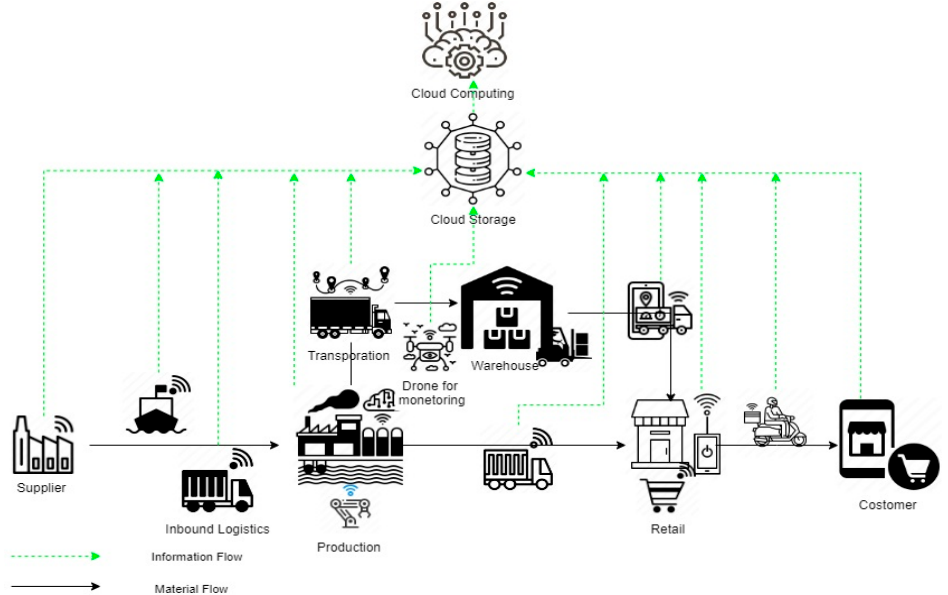
Figure 1. Conceptual structure of Logistics 4.0 (Source: Authors).